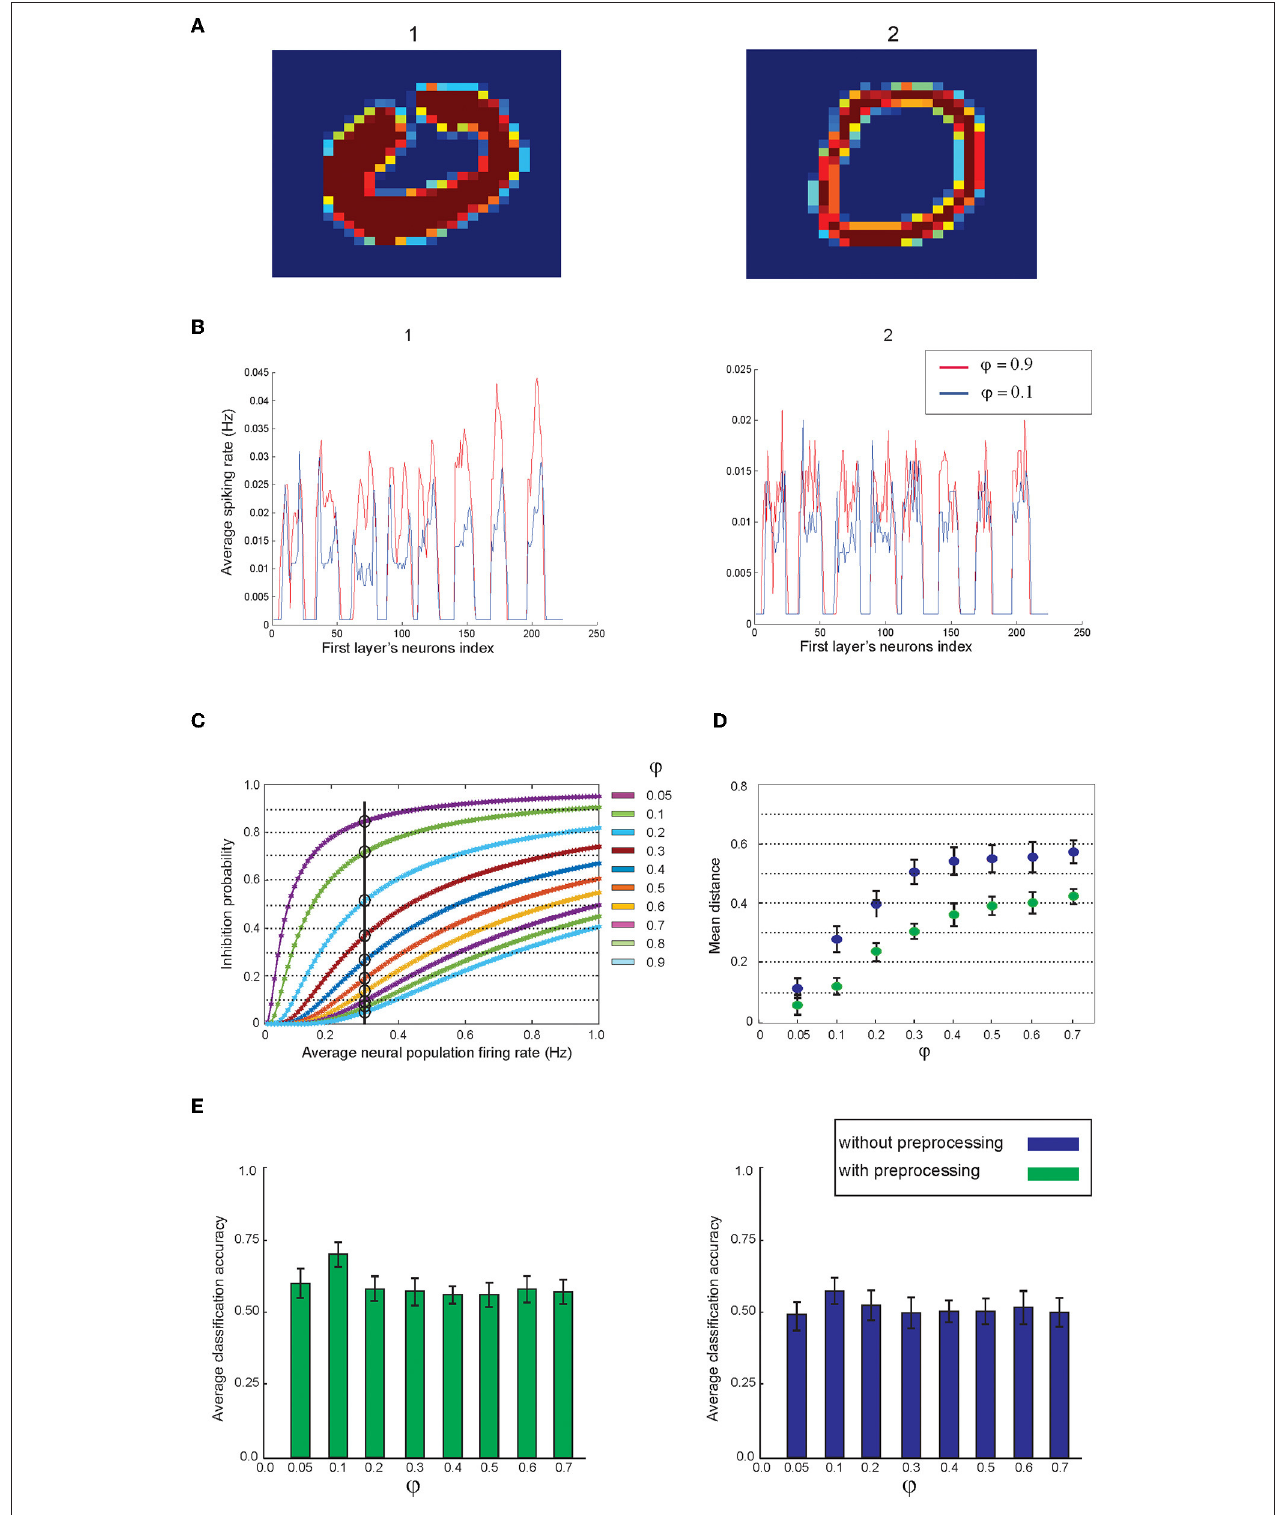
FIGURE 5 | The impact of feed-back inhibition on the neuronal representation of images by the first layer. (A) For each digit, there are many samples written thick and this normally makes noise in the pattern of the images from the same class. (B) In the model, feed-back inhibition with different parameter values are implemented in the first layer. The figure shows the neuronal representation of two images using low and high inhibition parameter values. (C) The dependency of the inhibition